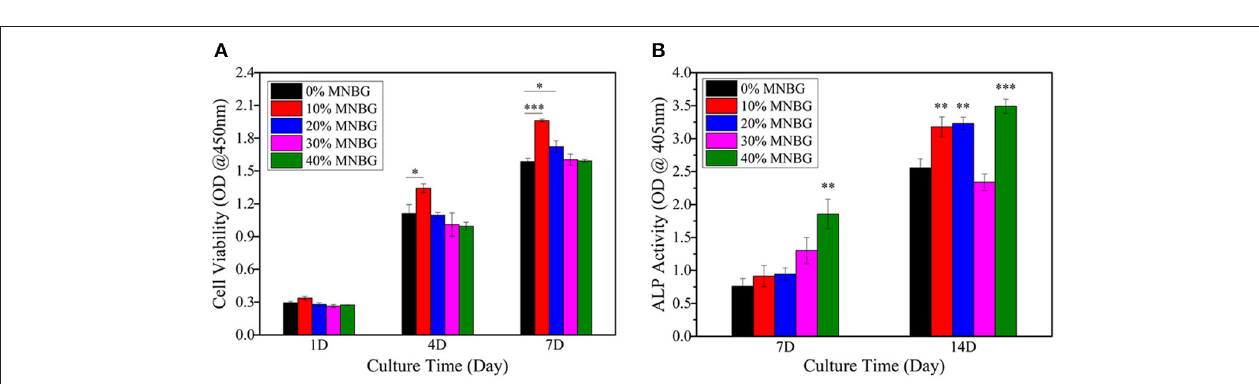
FIGURE 6 | Proliferation and ALP activity analysis of mBMSCs on PLGA-MNBG scaffolds. (A) CCK-8 assay indicating the cell proliferation at day 1, 4 and 7. (B) ALP activity test cells after incubated on various scaffolds for 7 and 14 days. (* p < 0.05, ** p < 0.01, *** p < 0.001 compare to 0% MNBG).